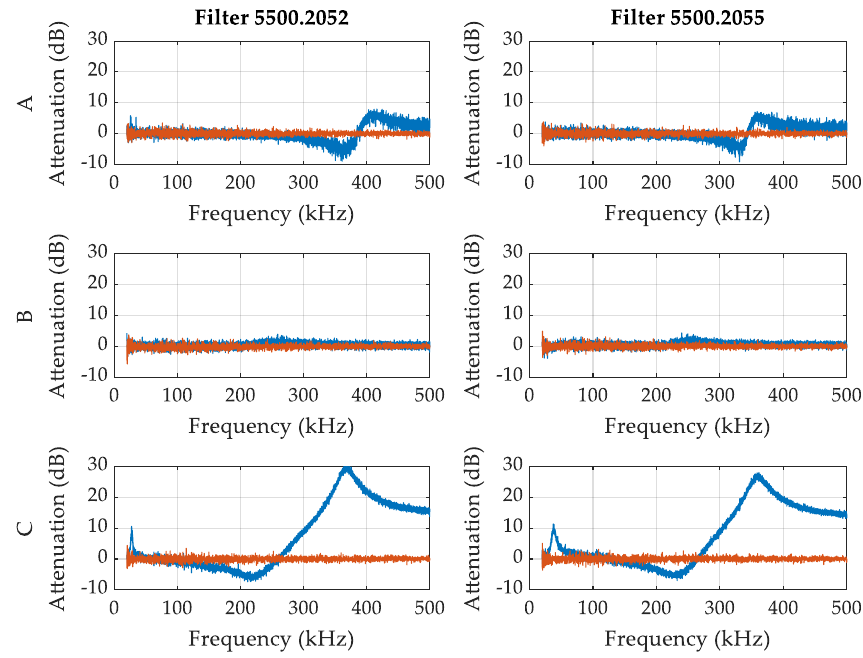
Figure 11. Attenuation of the EMC filters 5500.2052 and 5500.2055 reversed.